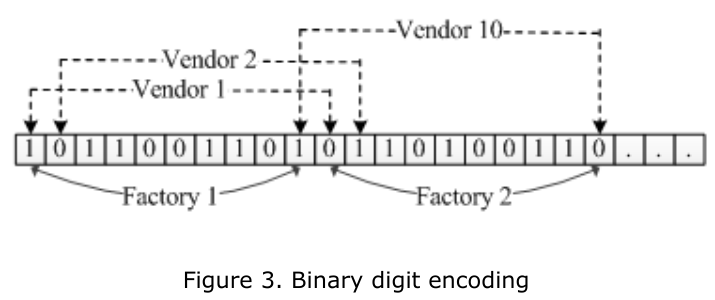
Figure 3. Binary digit